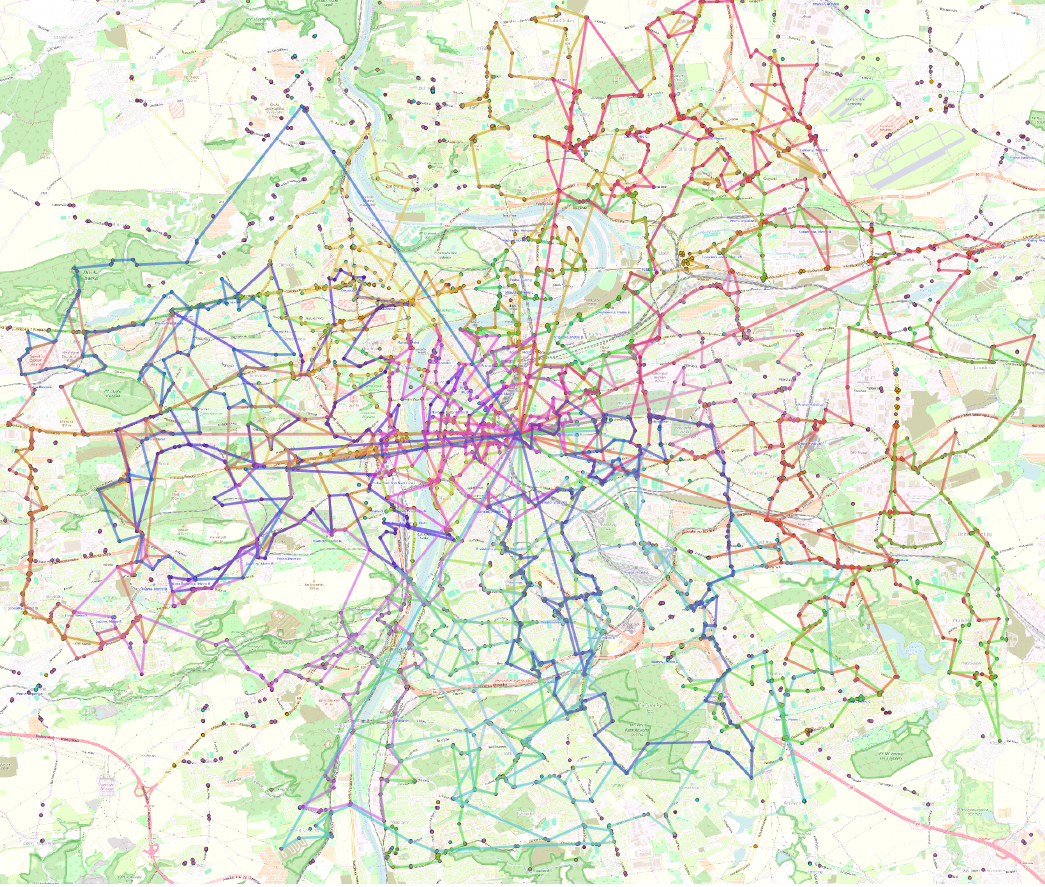
Figure 6. Planned trajectories for 20 UAVs tasked to monitor 3506 locations in Prague. Each location is required to be monitored by 3 different sensors giving 10,518 sensor tasks in total. DivPlan reached coverage of